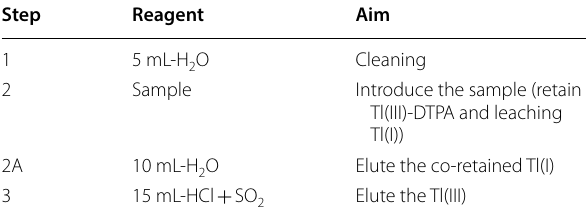
Table 1 The SPE procedure for separation of Tl(I) and Tl(III) from environmental aqueous